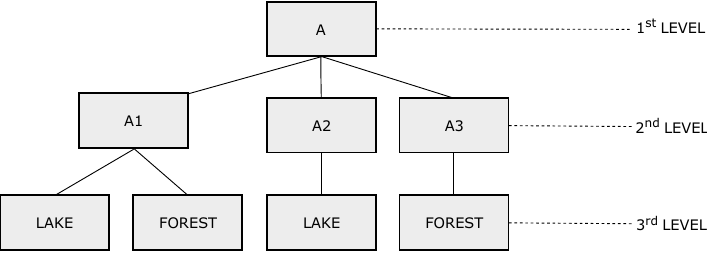
Figure 7. Name tree-hierarchy of component